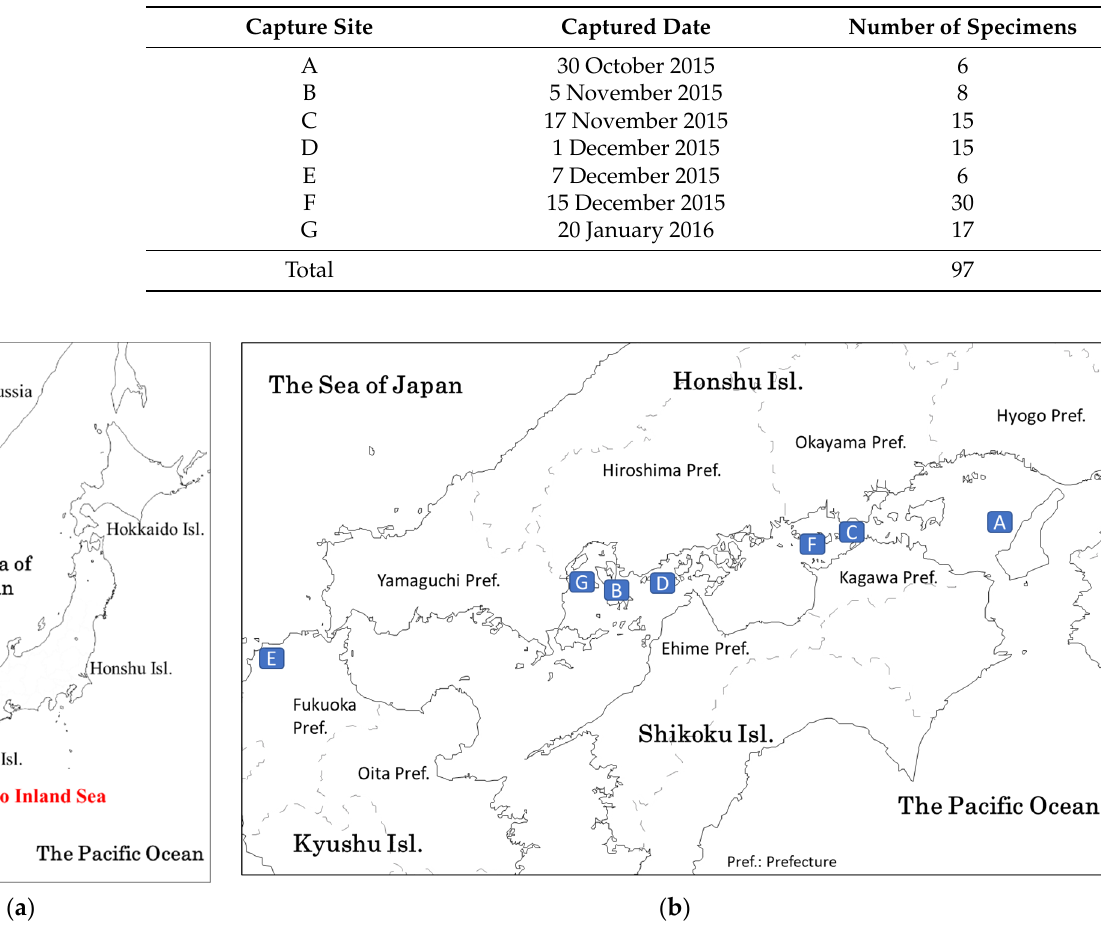
Figure 2. The location of the captured area of the pufferfish, Takifugu flavipterus , specimens. ( a ) Location of the Seto Inland Sea in Japan; ( b ) captured sites A to